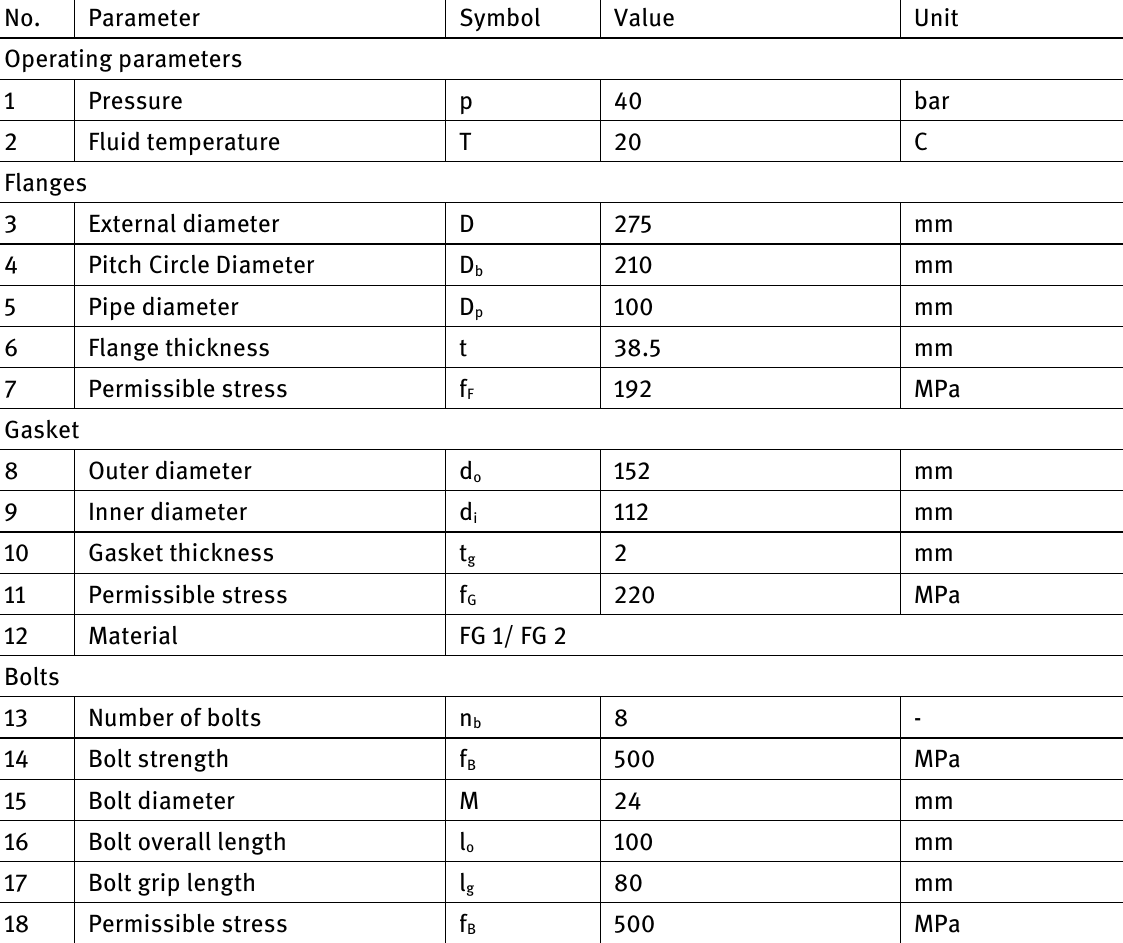
Table 1: Design data of the PN40 DN 100 flange-bolted joint